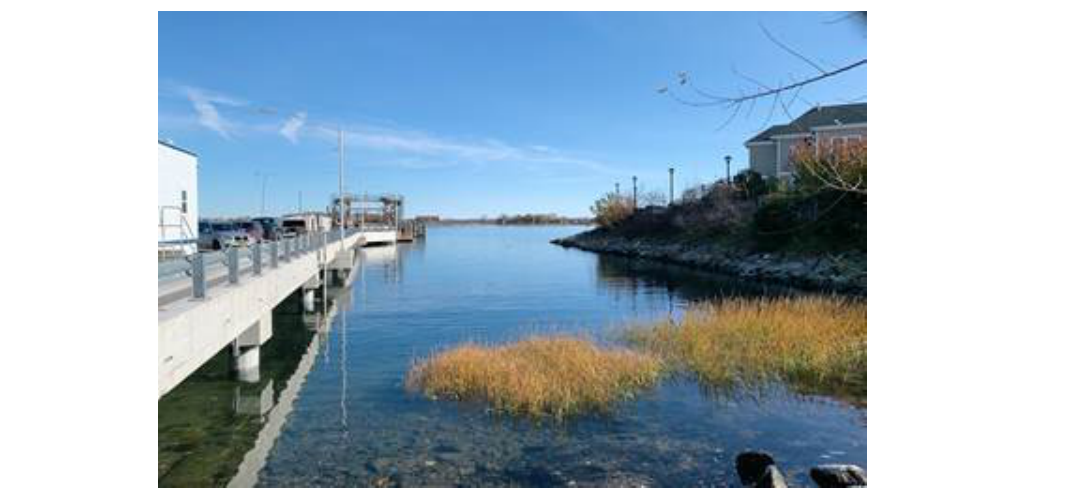
Figure 7. View of the dock on City Island, looking towards Hart Island, 2021 (Source: